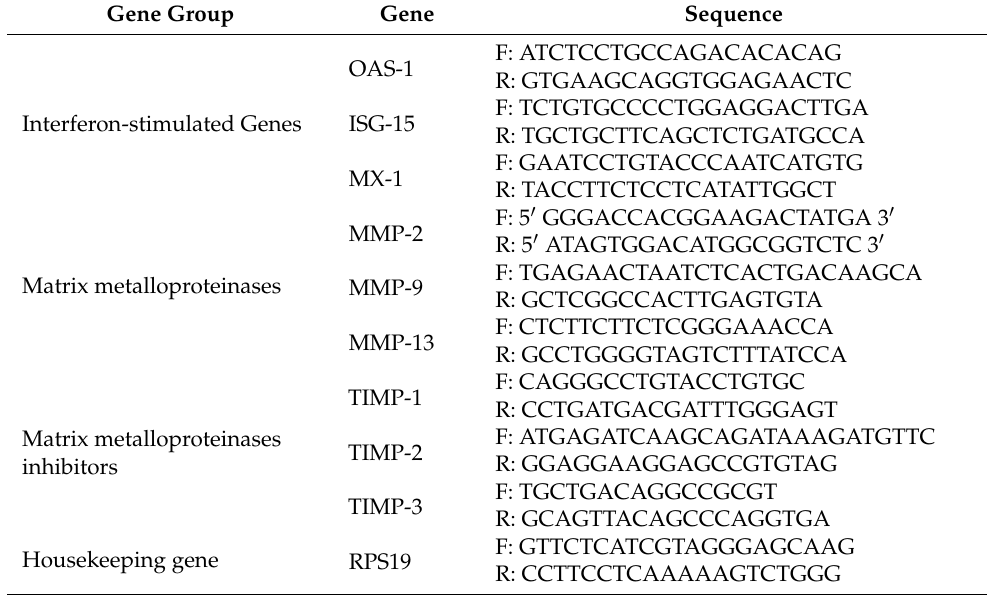
Table 1. Sequences of primers used for